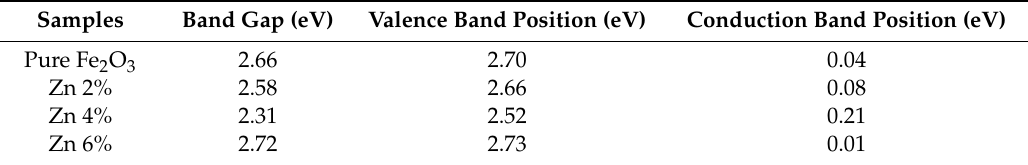
Table 2. The calculated band gap, valence band and conduction band positions corresponding to